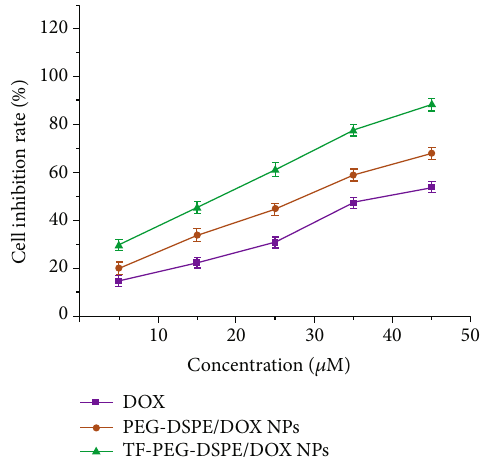
Figure 5: Inhibitory e ff ect of Adriamycin-loaded targeting nanoparticles on U87 glioma